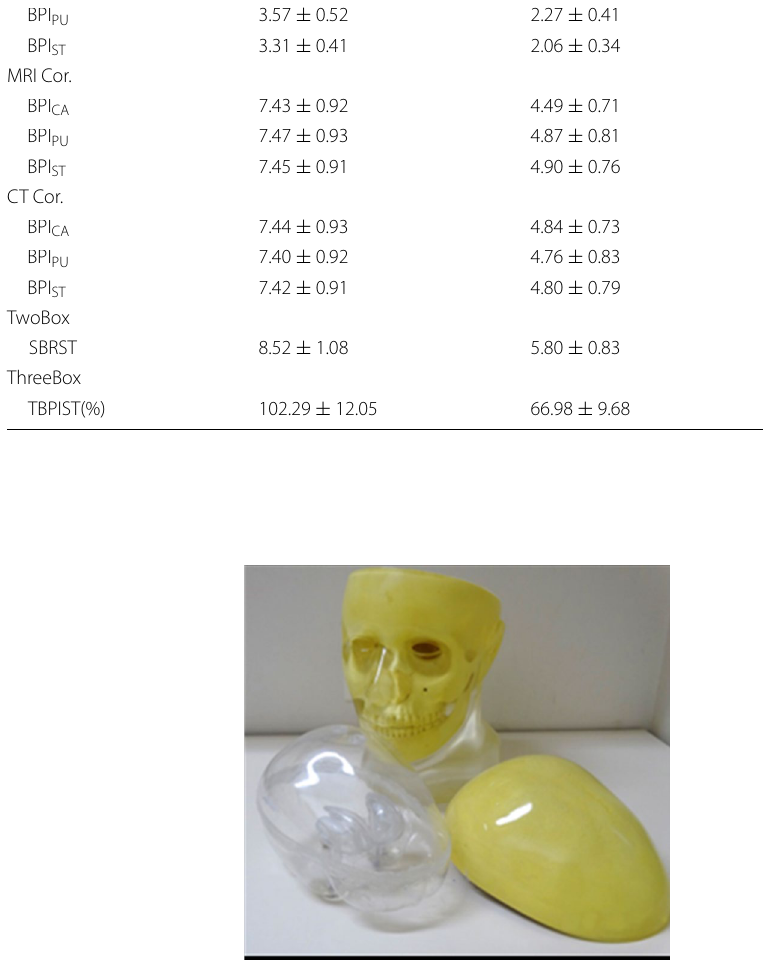
Fig. 1 Striatal anthropomorphic phantom Alderson RSD and skull to attenuation correction in equivalent